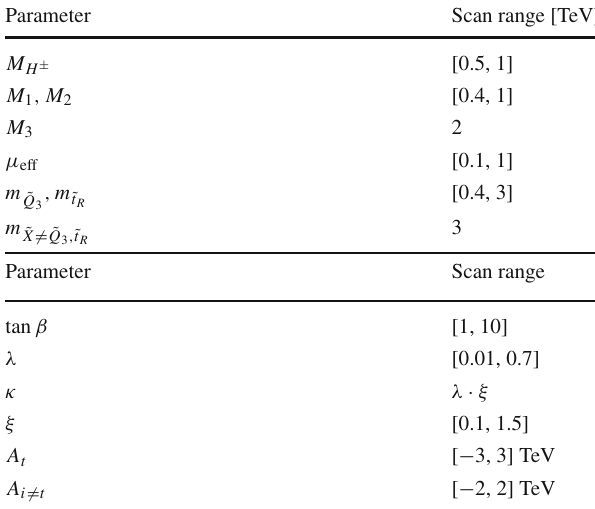
Table 1 Scan ranges for the random scan over the NMSSM parameter space, with ˜ X = ˜ b R , ˜ L , ˜ τ and i = b ,τ,κ . Values of κ = λ · ξ > 0 . 7 are